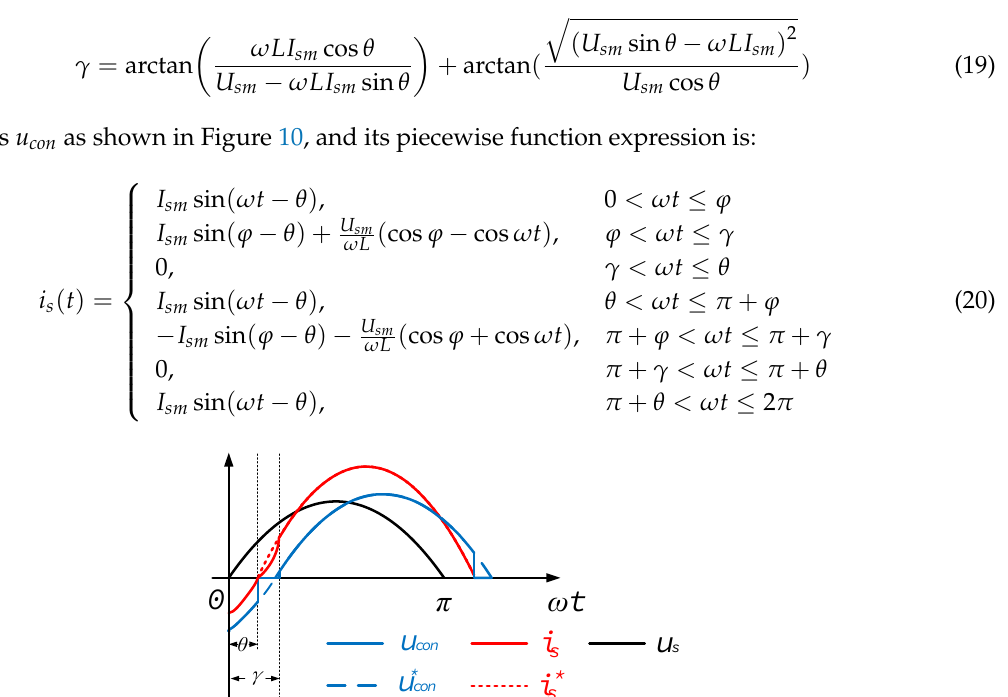
Figure 9. Expected waveforms and actual waveforms of AC-side fundamental voltage and current under a lagging power factor ( U L > | U s sin θ |).